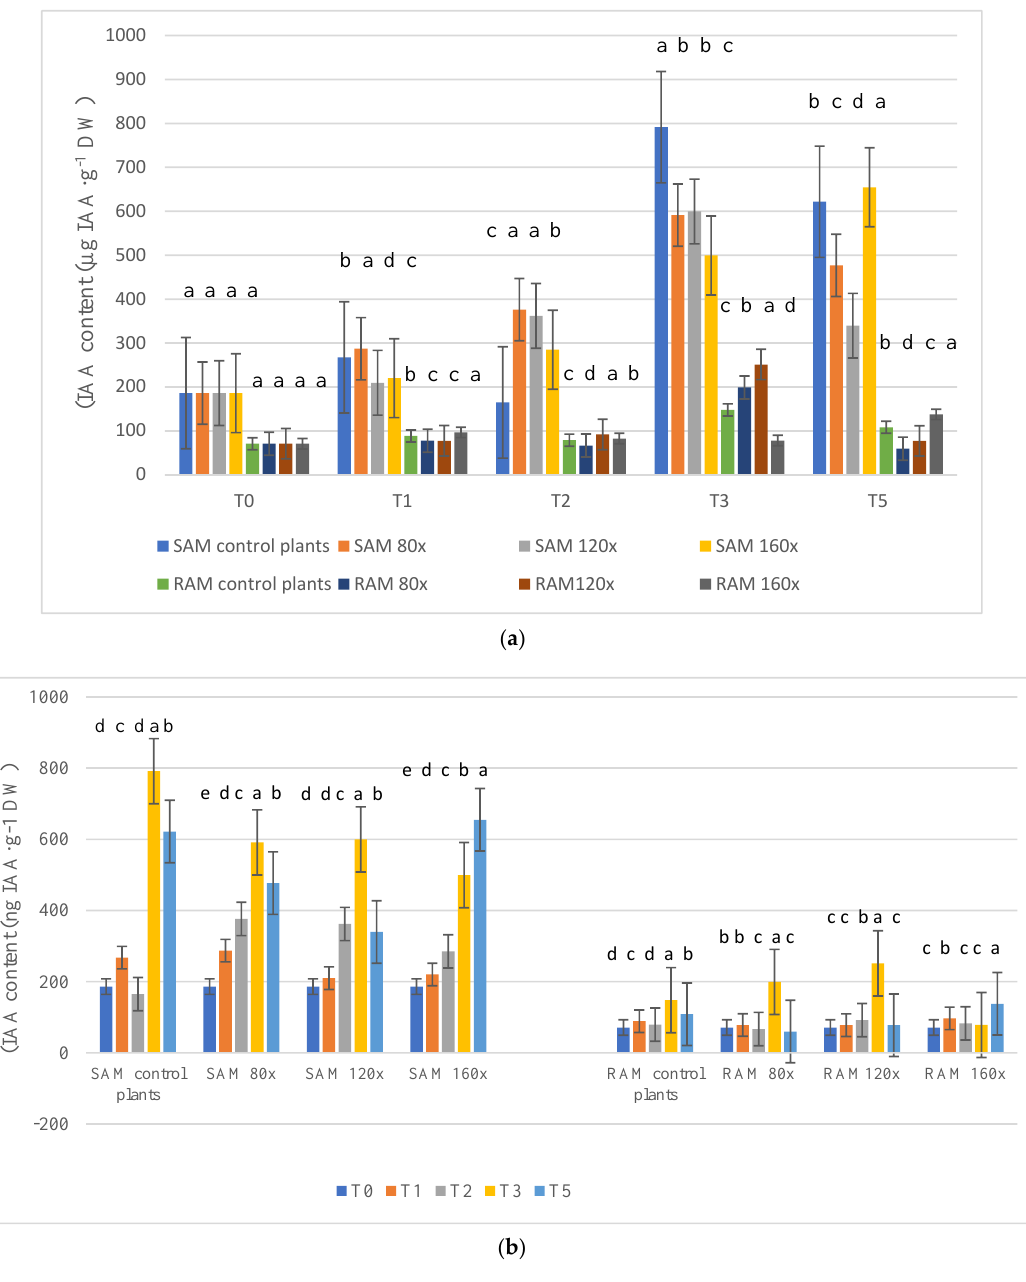
Figure 2. ( a ) IAA content (ng·g −1 DW) in the apical meristem of stems [SAM] and roots [RAM], analyzed separately, of petunias subjected to MS depending on stress intensity. The specimen was collected from 15 plants in each block from each treatment in each of the five terms (α − 0.05). ( b ) IAA content (ng·g −1 DW) in the apical meristem of stems [SAM] and roots [RAM], analyzed separately, of petunias subjected to MS depending on stress duration. The specimen was collected from 15 plants in each block from each treatment in each of the five terms (α − 0.05). The lowercase letters present statistical differences (α − 0.05) between the treatments.